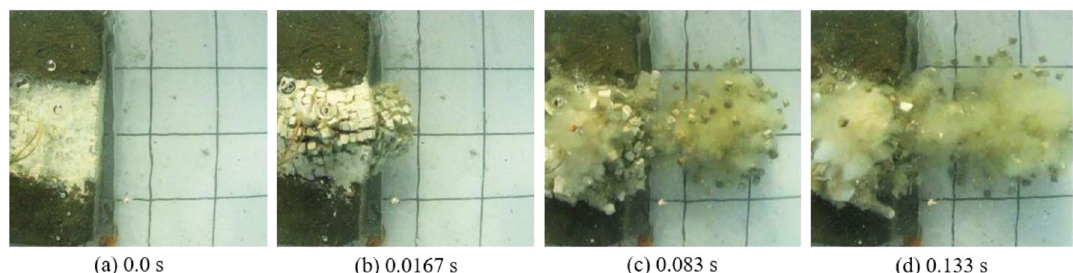
Figure 5. Underwater motion of blocks under a charge of 0.8 g.